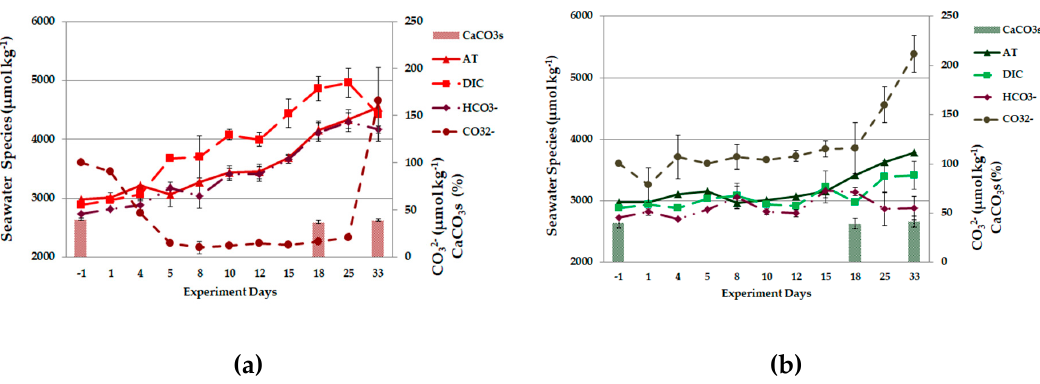
Figure 7. Total alkalinity, DIC, HCO 3 − and CO 32 − concentrations (in µ mol kg − 1 ) and sedimentary CaCO 3 s (in %) for the duration of the experiment for ( a ) OA and ( b ) C conditions (x-axis: days of the experiment; mean values and standard deviations for the two replicates of each treatment).